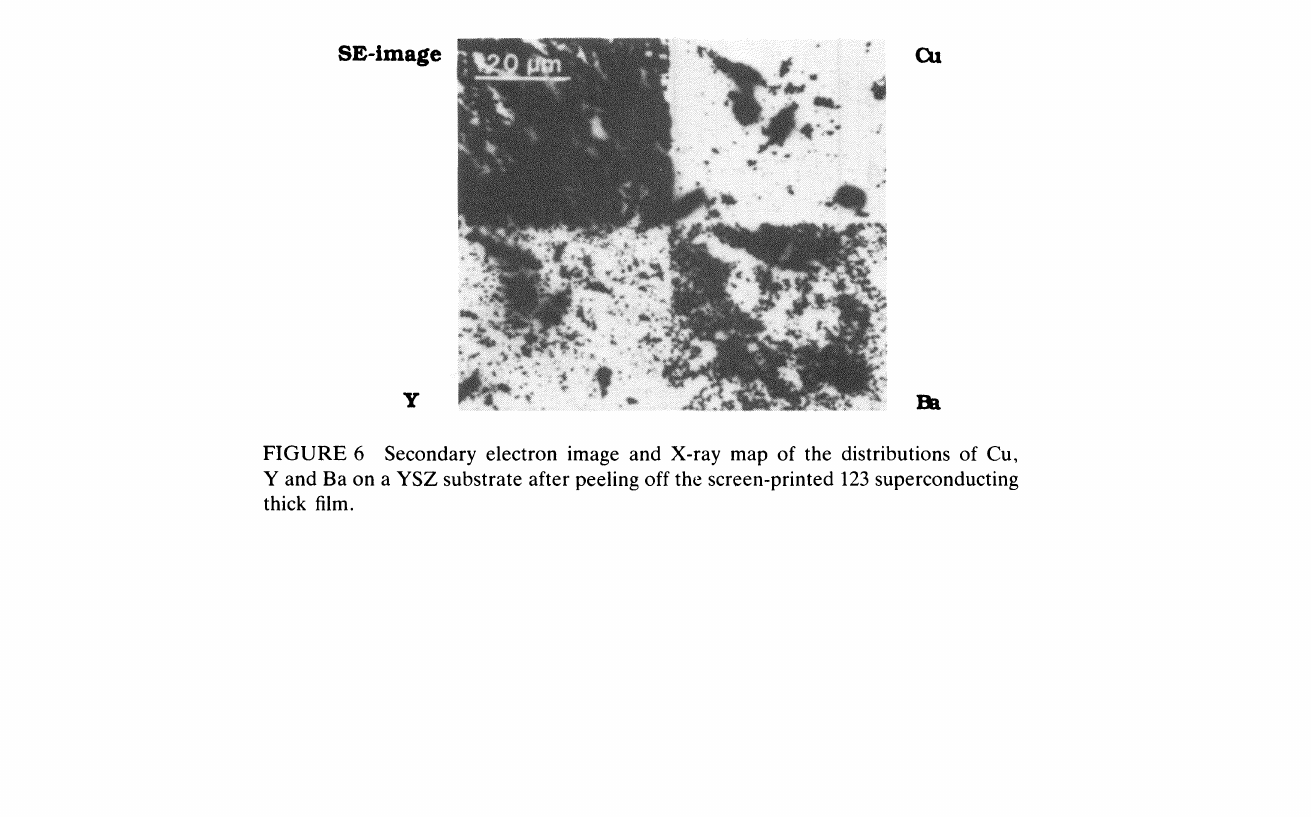
FIGURE 6 Secondary electron image and X-ray map of the distributions of Cu, Y and Ba on a YSZ substrate after peeling off the screen-printed 123 superconducting thick